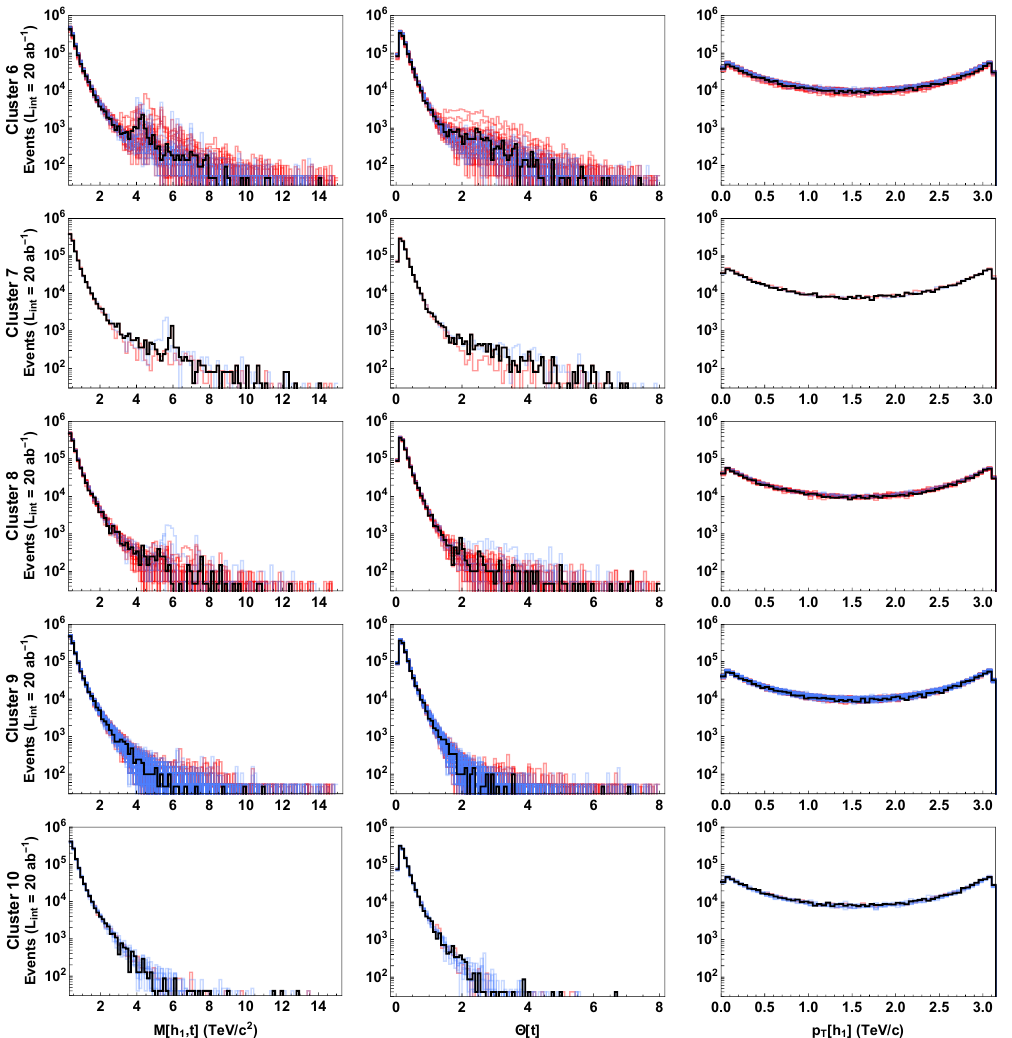
√ Figure 25 . Distributions at s = 100 TeV for the invariant mass of the pair composed by top and most energetic Higgs h 1 (first column), the top quark angle (second column) and the transverse momenta of h 1 (third column), organized in clusters by similarity (clusters 6 through 10). Red and blue curves indicate respectively points in Regions I and II of the MCHM 5 . The benchmark point for each cluster is shown in black, with clusters 6 to 10 containing respectively points E 6 to E 10 in table 7 of the main